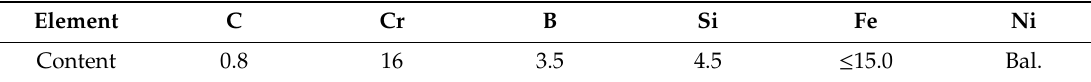
Table 2. Chemical composition of the Ni60 alloy powder (mass fraction %).